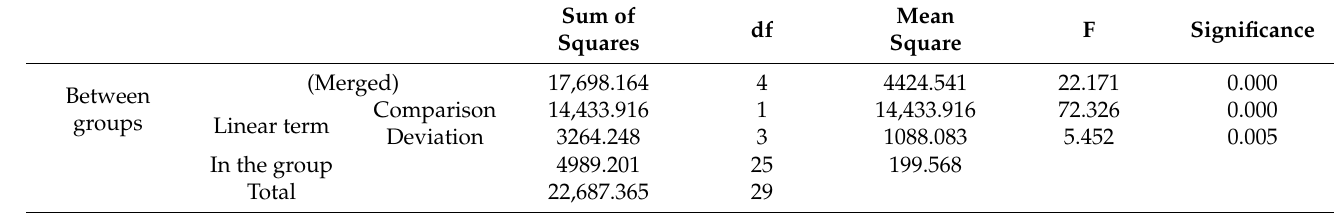
Table 10. Analysis of the variation number when the amount of fertilizer discharged is 0.41